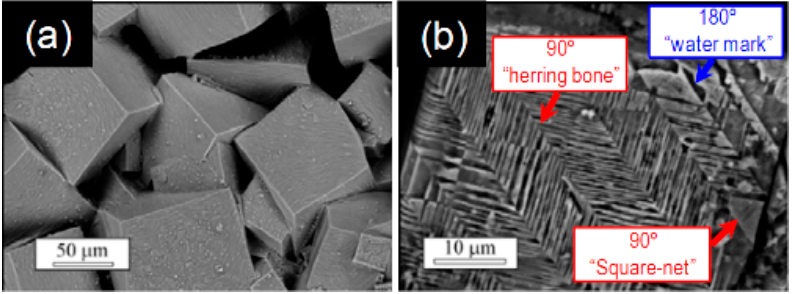
Figure 9. Scanning electron microscopy of the ( a ) grain structure and ( b ) domain structure revealed by chemical etching in KNN ceramics. Adapted from [59], with permission from © 2012 Royal Society of Chemistry.